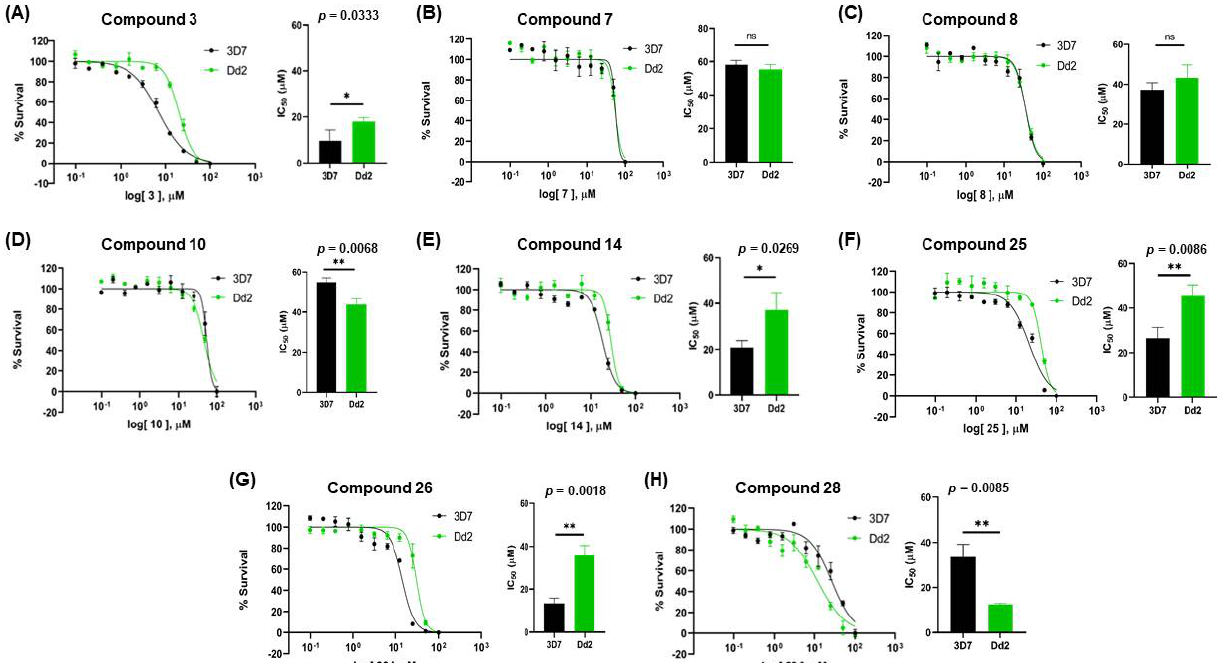
Figure 2. Determination of the antiplasmodial effects of 2-sulfenyl indoles on the 3D7 and Dd2 strains. Asynchronous parasites exposed to compounds 3 , 7 , 8 , 10 , 14 , 25 , 26, and 28 for 72 h in the range of 0.1–100 µM. Parasitemia was obtained using a flow cytometer by double staining parasites with SYBR and MitoTracker. Dot plot analysis of each drug concentration tested allowed us to determine parasitemia. Growth survival curves of blood-stage P. falciparum of compounds. Growth survival curves of blood-stage P. falciparum of compounds 3 ( A ), 7 ( B ), 8 ( C ), 10 ( D ), 14 ( E ), 25 ( F ), 26 ( G ), and 28 ( H ) for 3D7 (black) or Dd2 (green). Data represent three independent experiments performed in triplicate. The bar graphs represent the SD. Statistical significance was calculated using Student’s t-test: ns = not significant, * p ≤ 0.05, ** p ≤ 0.01.